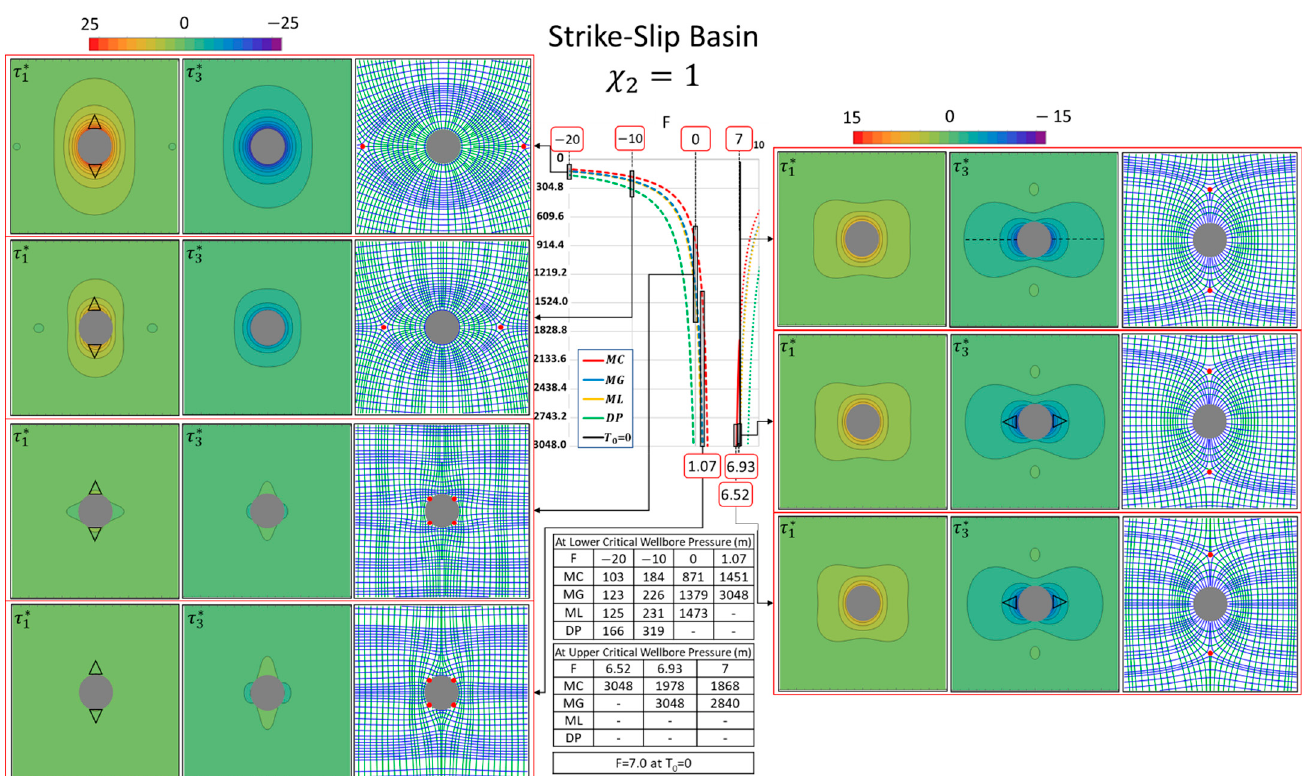
Figure 10. Dimensionless deviatoric stress magnitudes and trajectories for the strike-slip basin case at upper-bound (left-hand side) and lower-bound shear failure (right-hand side). For the zero tensile strength, tensile failure will occur at F = 7.0. The color indices above the magnitude plots indicate the local stress intensity is normalized by the larger (compressional) far-field stress (see Appendix B.4). The triangles and dashed lines on the magnitude plots of the maximum principal stress at shear failure and of the minimum principal stress at tensile failure show the expected locations of failure. The blue and green curves, and the red dots in the stress trajectory plots represent the maximum and minimum principal stress trajectories, and the neutral points, respectively. The tables beneath the F curves show the depths for each F value calculated by the Mohr–Coulomb (MC), Mogi–Coulomb (MG), modified Lade (ML), and Drucker–Prager (DP) failure criteria.